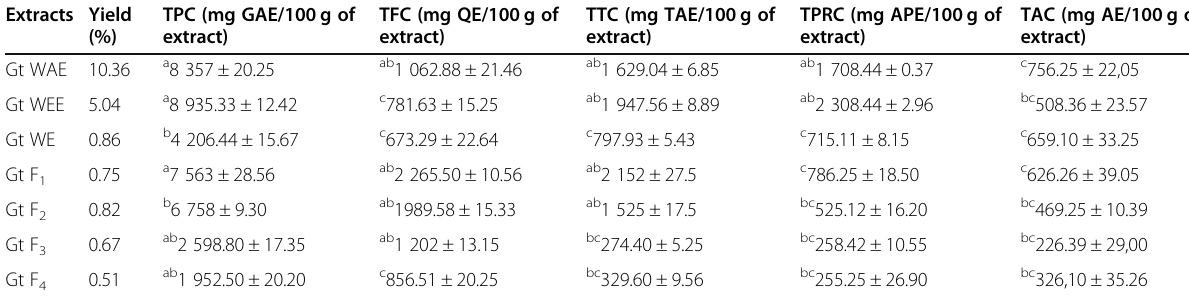
Table 4 Total phenolic content, total flavonoid content, total tannins content, total proanthocyanidins content and total alkaloid content of extracts from Guibourtia tessmanii J.